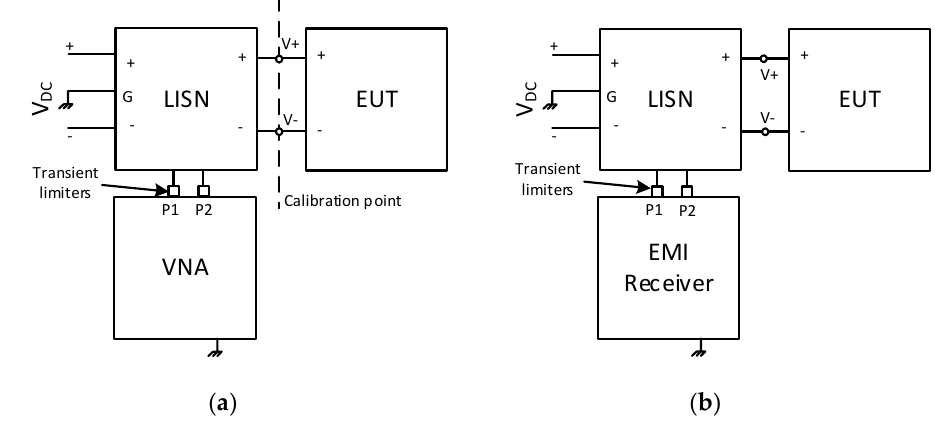
Figure 4. ( a ) S-parameter measurement setup; ( b ) CE measurement setup.